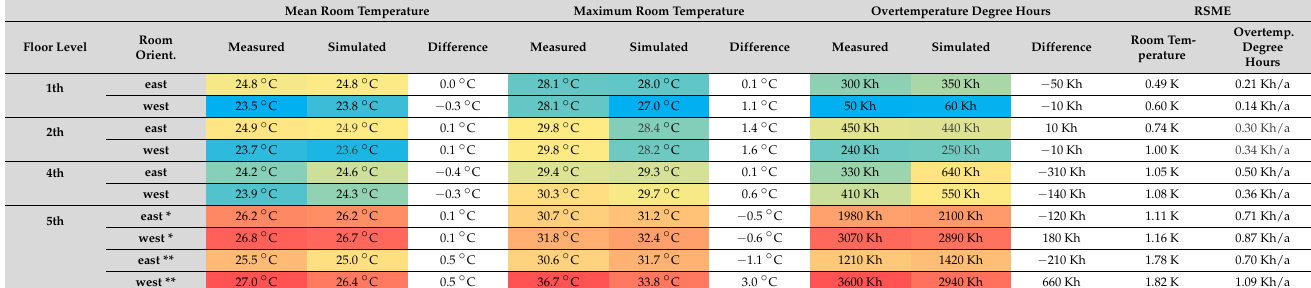
Table 3. Comparison of measured and simulated mean and maximum room temperature as well as overtemperature degree hours above 26 ◦ C for the ten monitored rooms from 3 June until 8 September 2019 (time span includes the presence of residents). The colors indicate an overheating intensity scale from low (blue) to high (red). The root mean square error (RMSE) for the measured to simulated room temperature and overheating degree hours acts as indicator for statistical reliability (* dwelling 1, ** dwelling 2). MeanRoomTemperature MaximumRoomTemperature OvertemperatureDegreeHours RSME FloorLevel Room Orient.